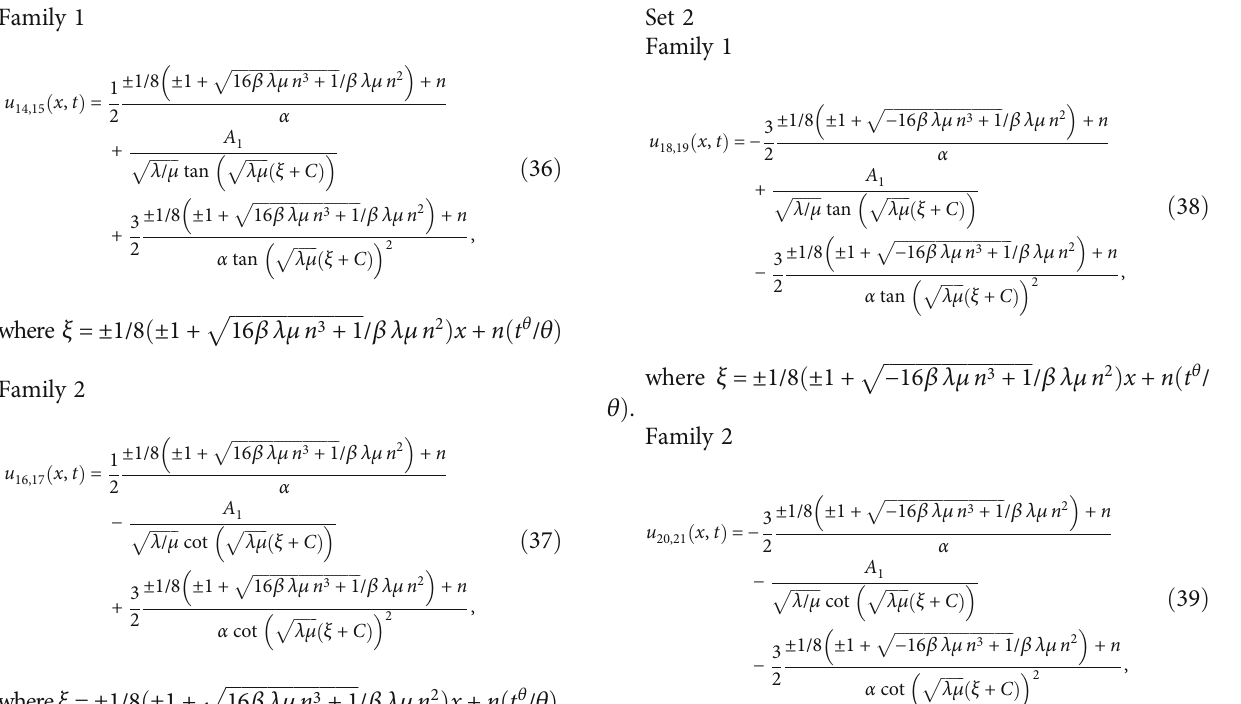
Figure 12: Dynamical behavior of function solution of u